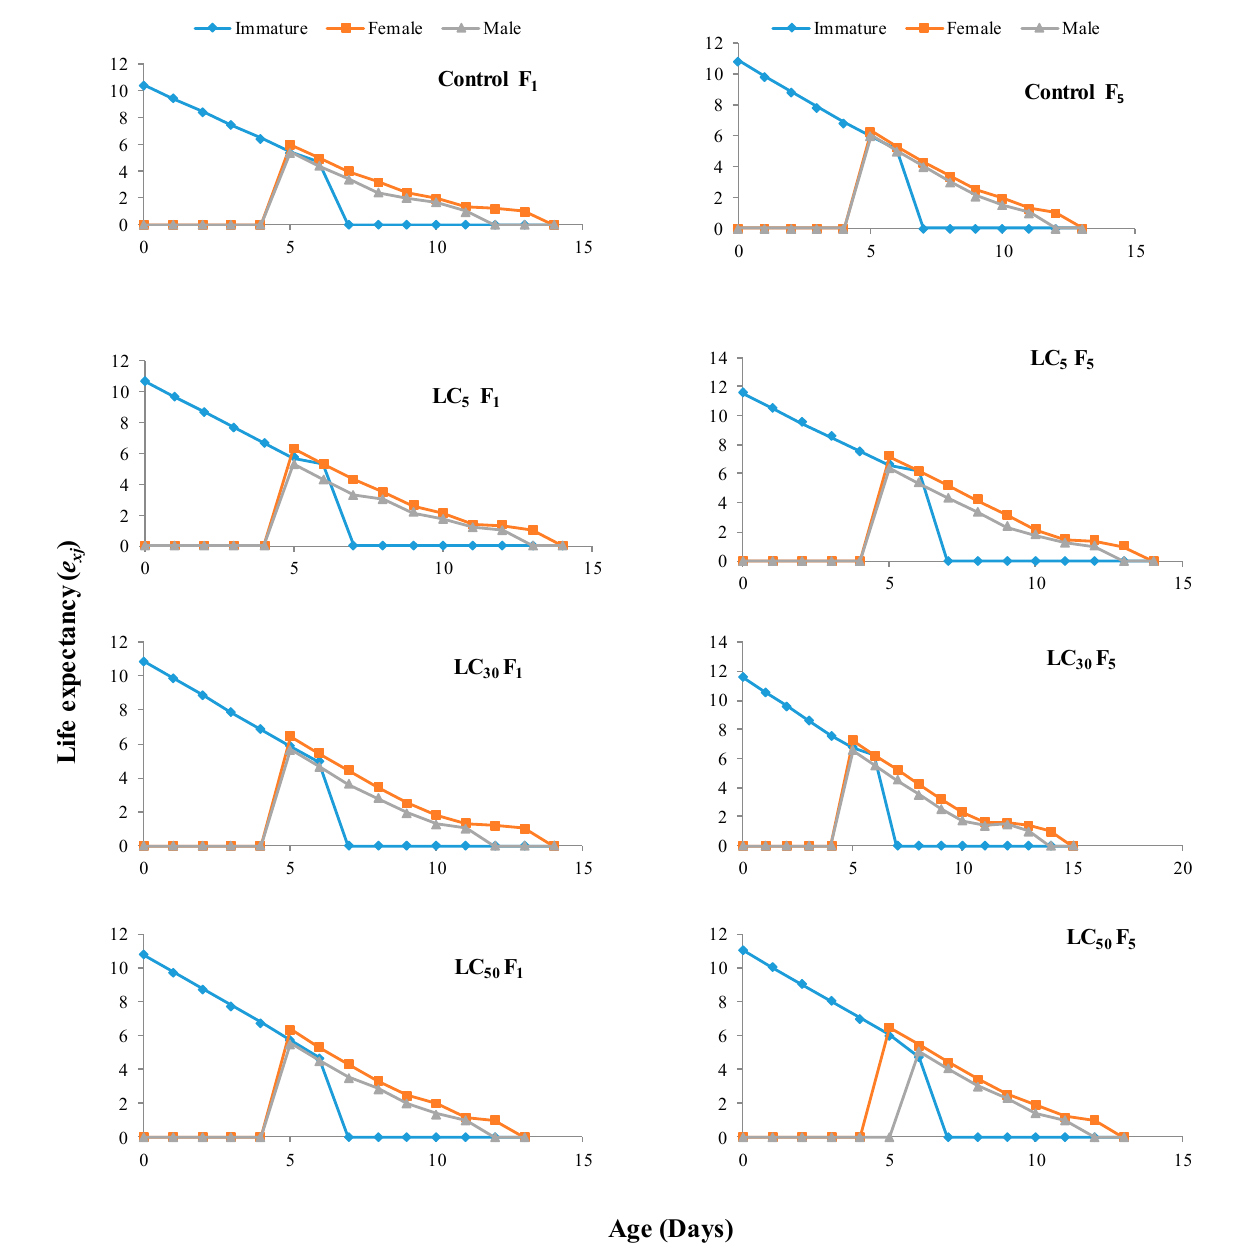
Figure 3. Age–stage–specific life expectancy ( e xj ) of T . chilonis adults of imidacloprid in F 1 and F 5 generations.